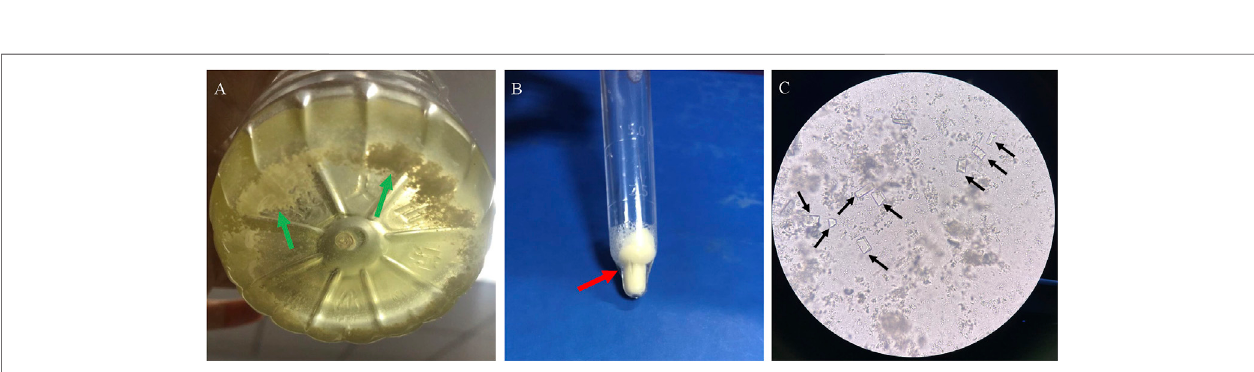
FIGURE2| Crystallineurineinpatient8ofLND. (A) :Smallwhitecrystalsdepositedinurine (B) :smallcrystalsaftercentrifugalprecipitation, (C) :microscope(×200): square columnar magnesium ammonium phosphate crystal with strong refraction (black arrow).